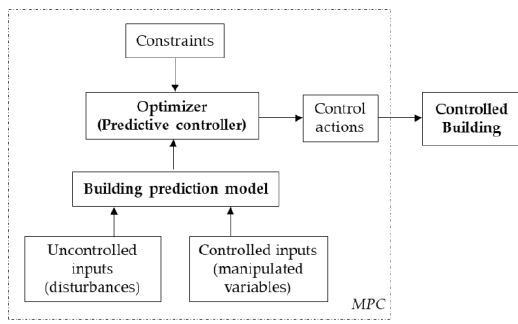
Figure 1. Architecture of a typical building’s model predictive control (MPC).